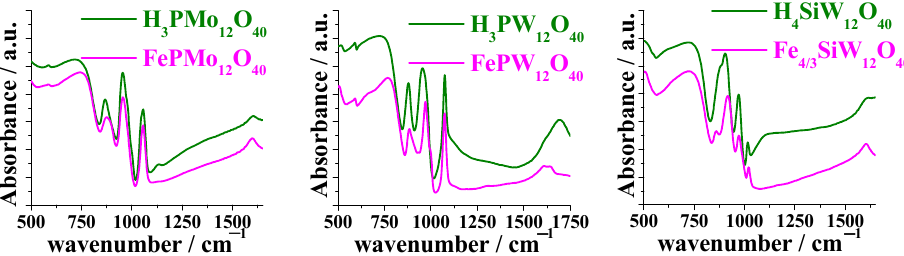
Figure 4. Infrared spectra of phosphotungstic, silicotungstic, and phosphomolybdic acid and their iron-exchanged salts (adapted from refs. [34,35]).